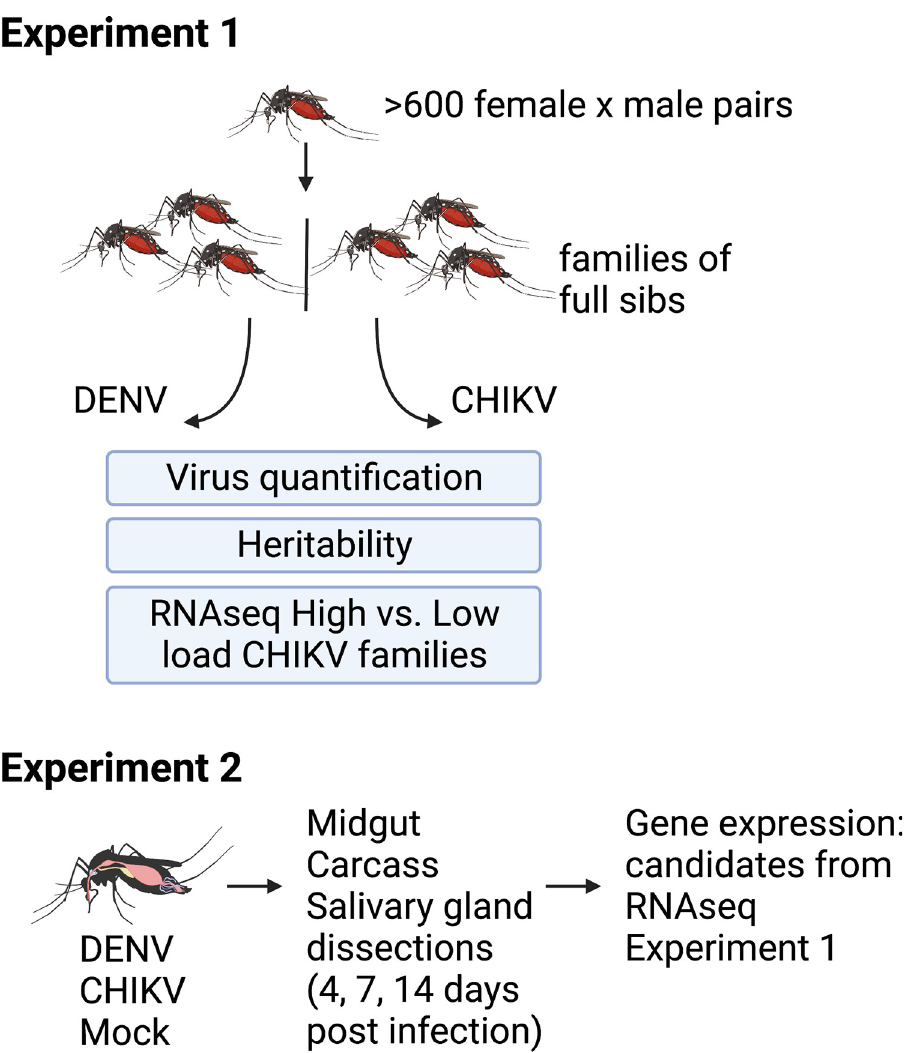
Fig 1. Overview of experimental design. In experiment 1, we studied CHIKV and DENV loads in siblings from single female x male pair crosses and calculated the heritabilities and genetic correlations of the loads. We then carried out RNAseq comparing two groups; families with the four highest and four lowest mean CHIKV loads. In experiment 2, we reared a separate set of mosquitoes from the same population and exposed them to CHIKV, DENV, or mock (uninfected cell culture control) infection through blood-feeding treatments and then dissected key tissues (midgut, carcass, salivary glands) at three timepoints post-infection (4, 7, 14). We then examined patterns of gene expression of the top candidate gene from the RNAseq analysis in experiment 1 across treatments and tissues x time. Created with BioRender.com.